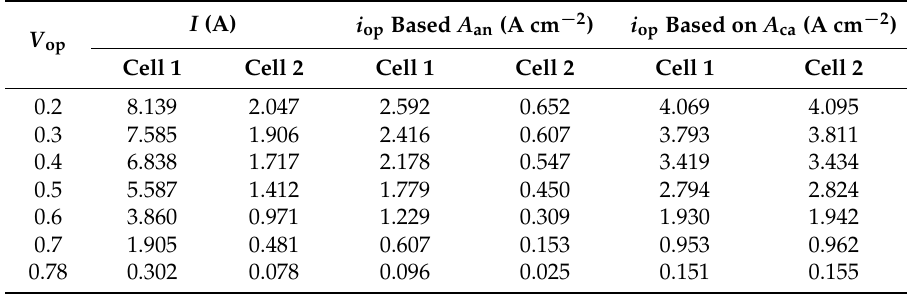
Table 2. For a specified V op , comparing the responded i op that are evaluated by divided I op with A an for larger value and A ca for lower value, respectively.